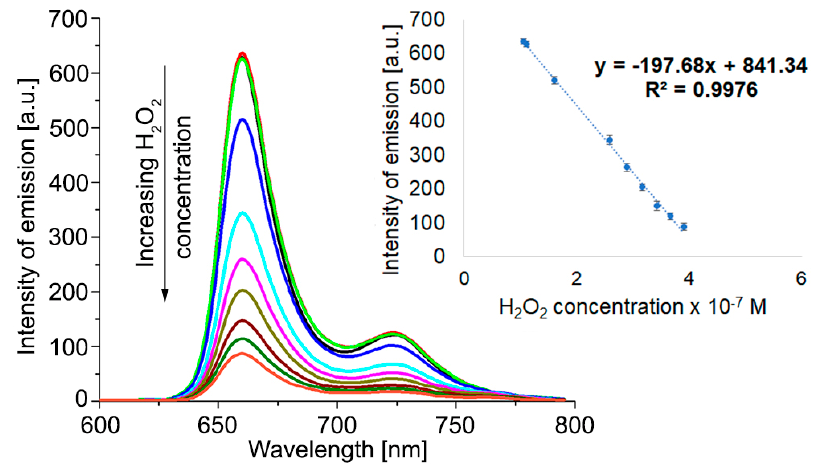
Figure 5. Effect of H 2 O 2 on the fluorescence spectra of Pt(II)-TAPP, recorded in DMSO. Linear dependence between the intensity of emission of Pt(II)-TAPP, read at 660 nm, and the H 2 O 2 concentration.